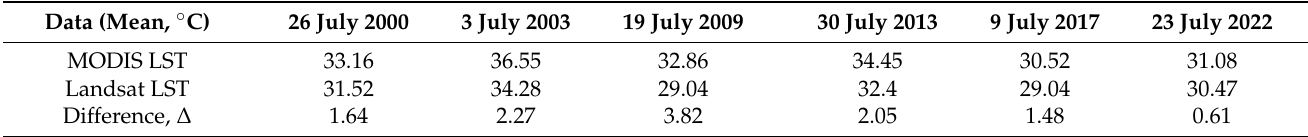
Table 3. The mean values and differences calculated.